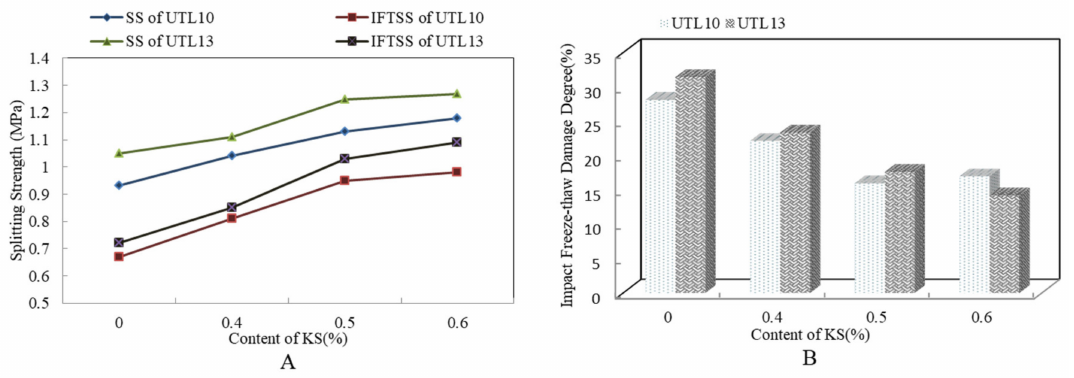
Figure 7. Results of impact freeze-thawing spilt test with di ff erent KS contents: ( A ) SSW and IFTSS; ( B )